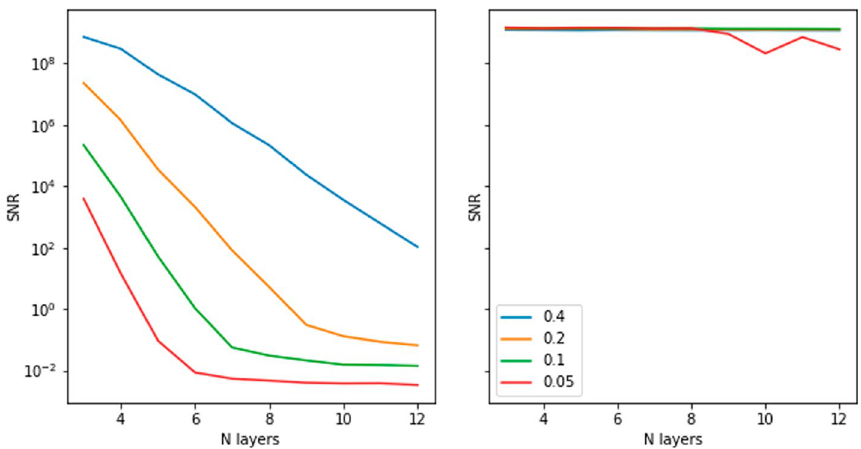
Fig. 11 Illustration of the impact of depth (in number of layers N ) and negative slope n on the numerical errors of (left) the layer-wise invertible architecture and (right) the hybrid architecture. Both figures show the evolution of the SNR at the input layer of the network for increasing depth N on the x axis, and with different negative slopes n in different colors. (Left): the SNR decreases with depth until it reaches an SNR value of 1. At this point, the noise is of the same scale as the signal, and no learning can happen. It is impressive that with only four layers of depth, a negative slope of n = 0.005 reaches a SNR of 1. With such parameterization, even the most shallow models are not capable of learning. (Right) The hybrid architecture successfully stabilizes the numerical error propagation